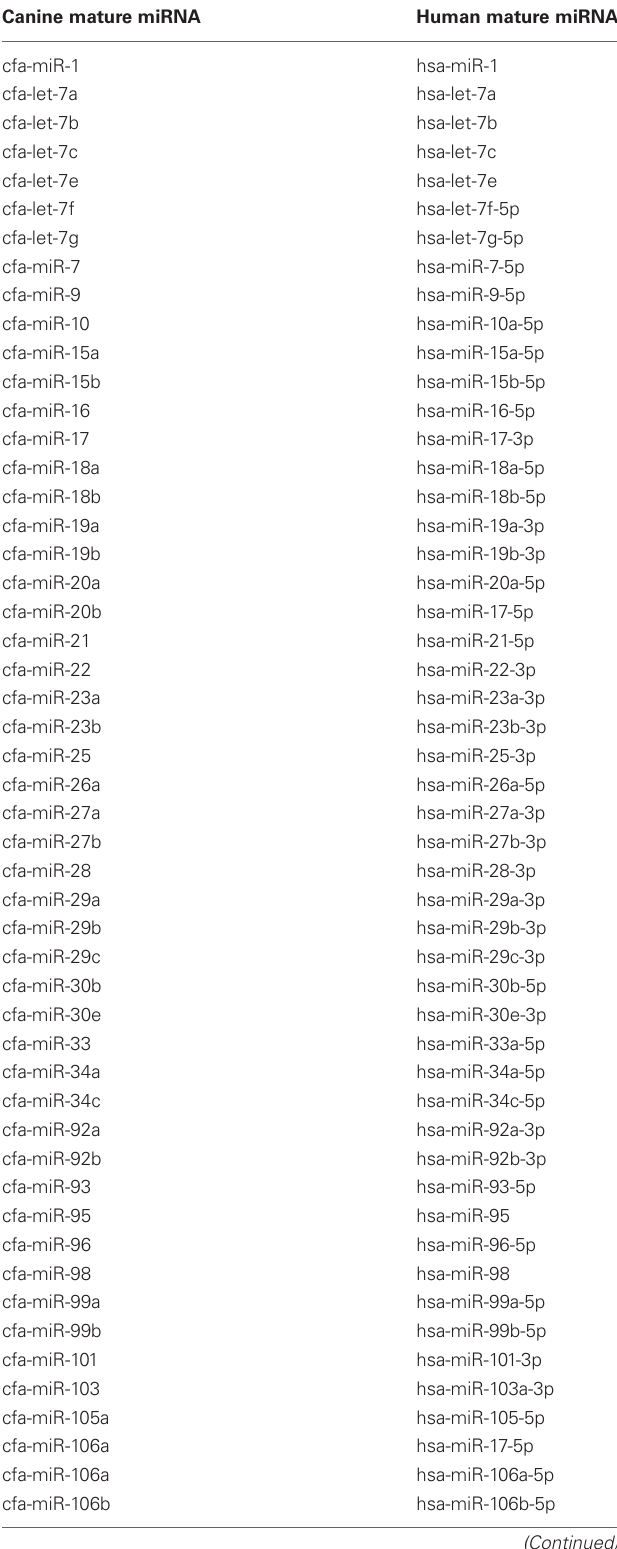
Table 1 | Comparison of canine and human mature